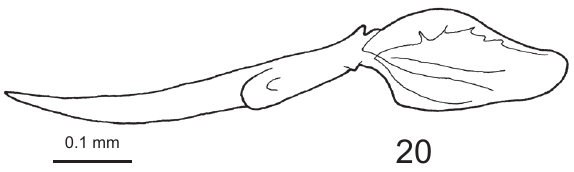
Figure 20. Pampsilota leleupi : Penis valve (left, lateral